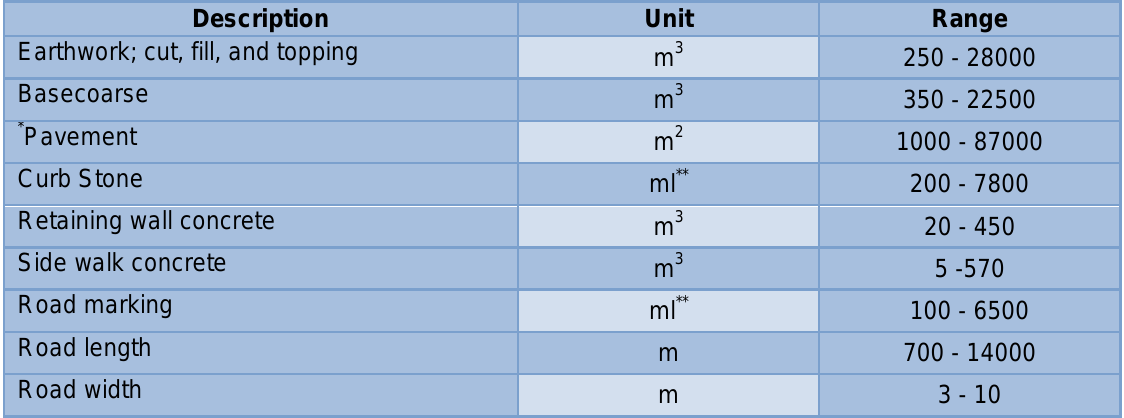
Table 6 Input variables description in the collected data set